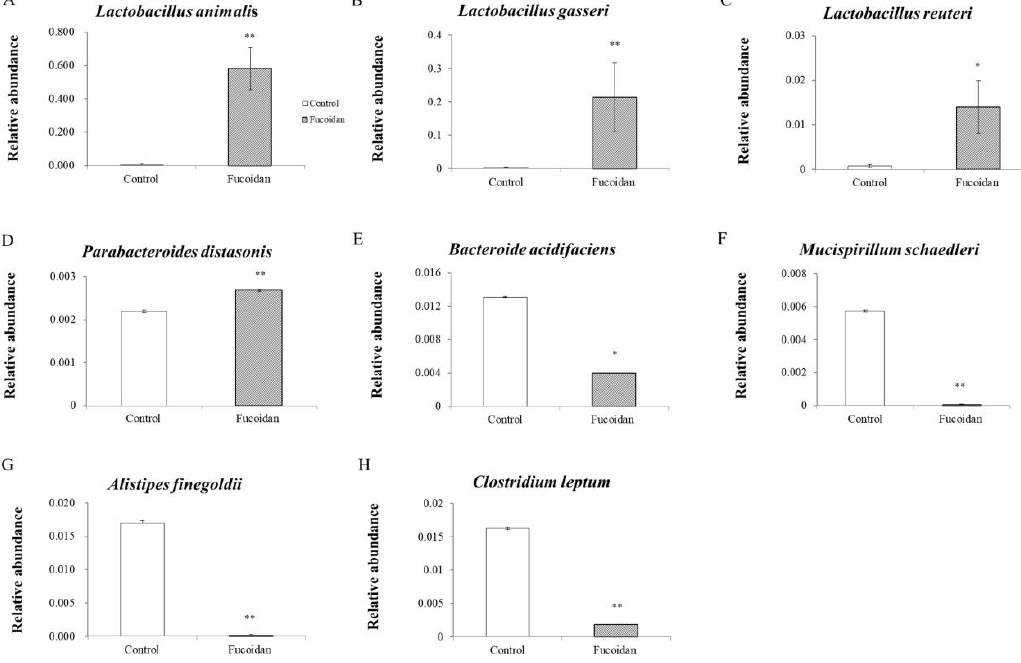
Figure A4. Fucoidan supplementation caused distinct shifts in the ( A – H ) bacterial species in mice. * p < 0.05, ** p < 0.01. Blank square, control group; grey square, fucoidan group.